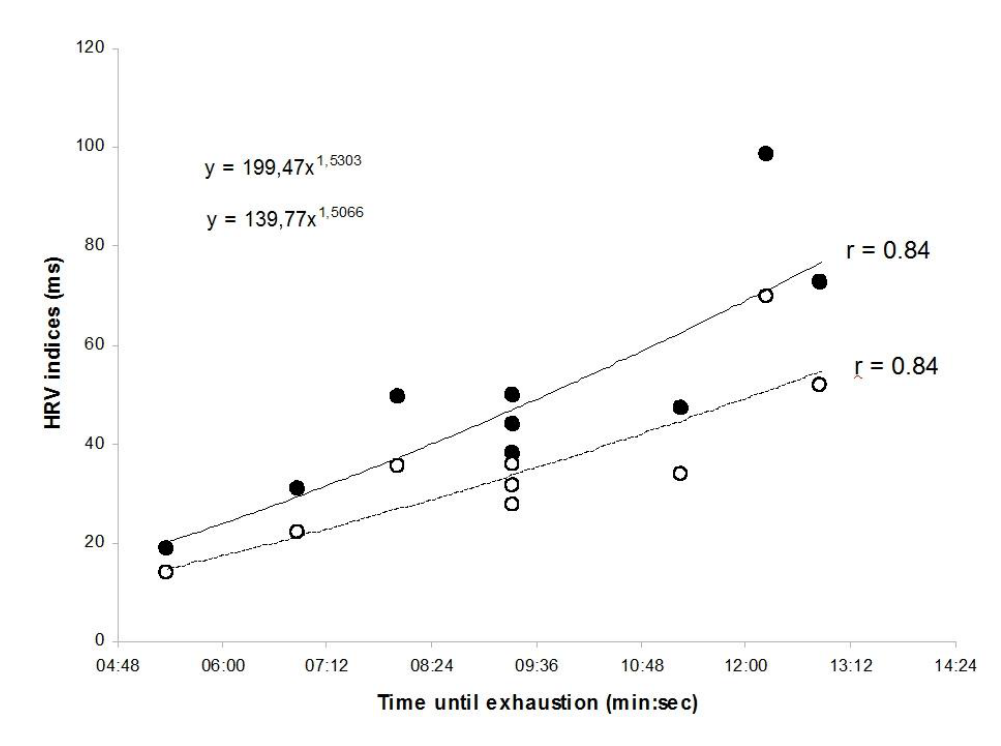
Figure 2. Exponential regression (n = 8) of AUC for SD1 (dotted line; white circles) and RMSSD (thick line; black circles) with exhaustion time in Yo-Yo intermittent recovery test level 1; r = Pearson product correlation